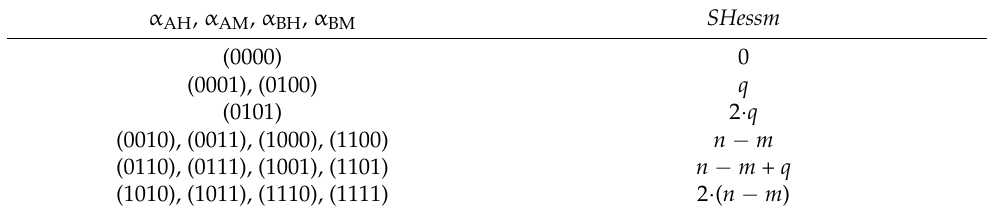
Table 2. Left-shift for the generalized ESSM